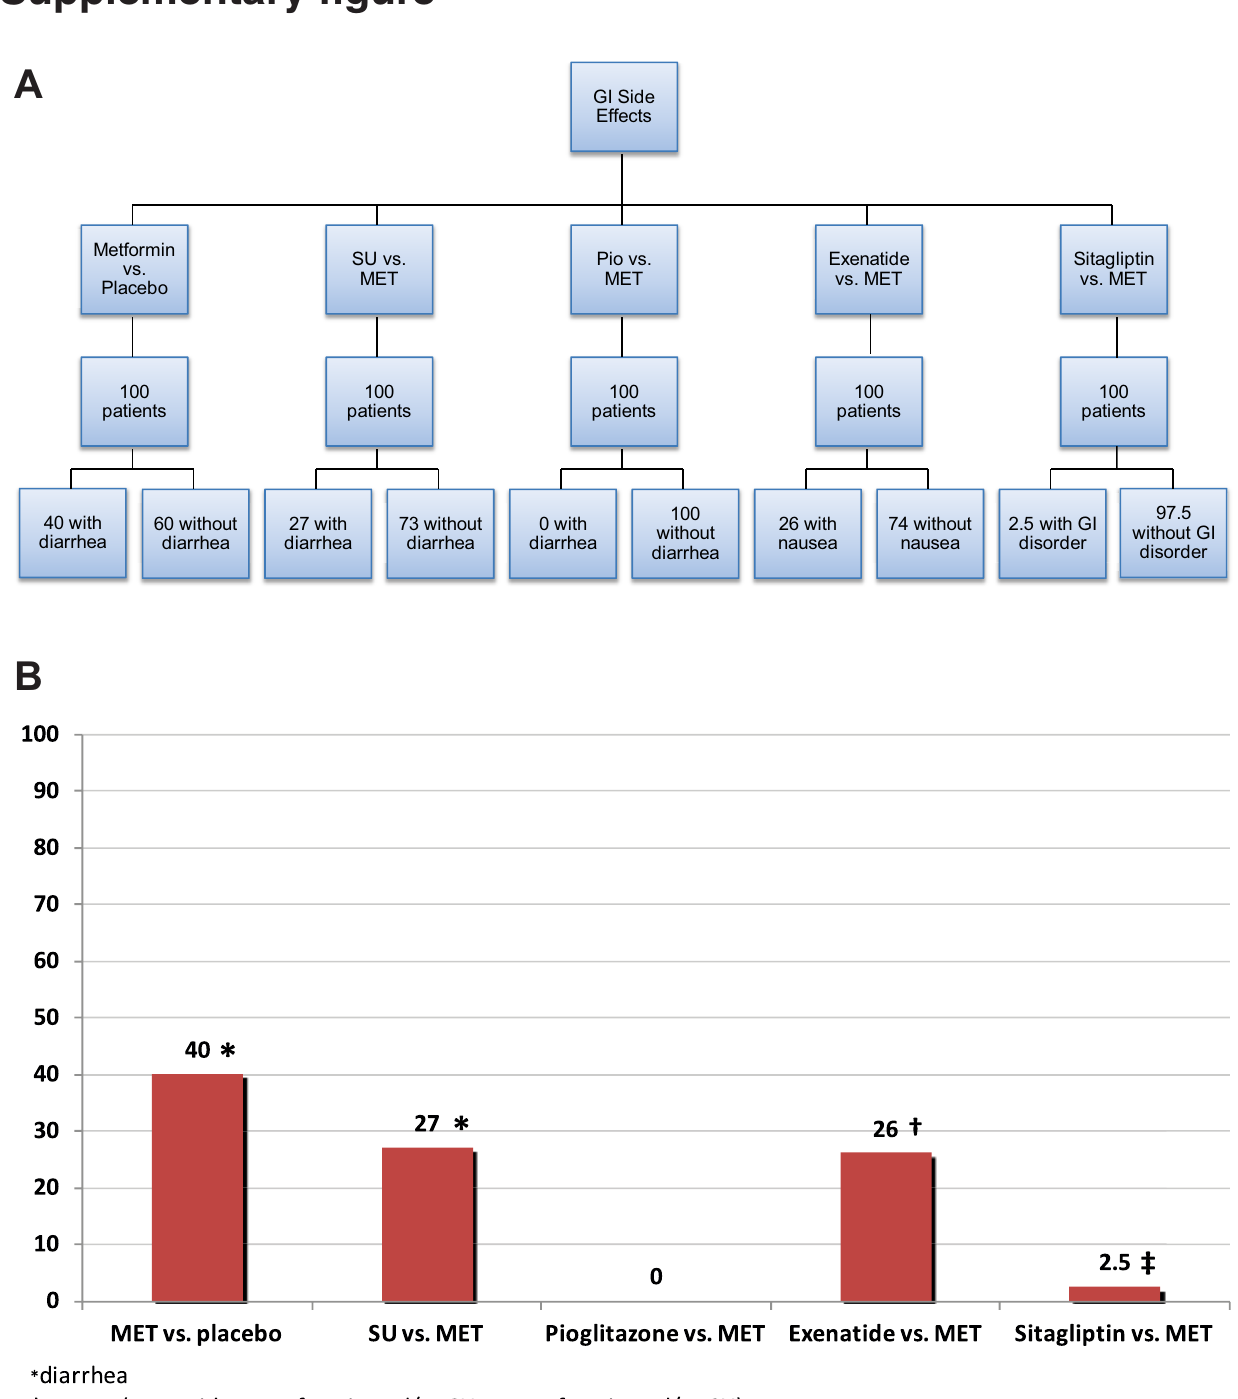
Supplementary Figure 1. Visual representations of data. A ) The flow chart shows the occurrence gastrointestinal (GI) side effects by diabetes medication pair. B ) Bar chart shows excess number of patients per 100 with GI side effects. SU-Sulfonylureas; MET-Metformin;